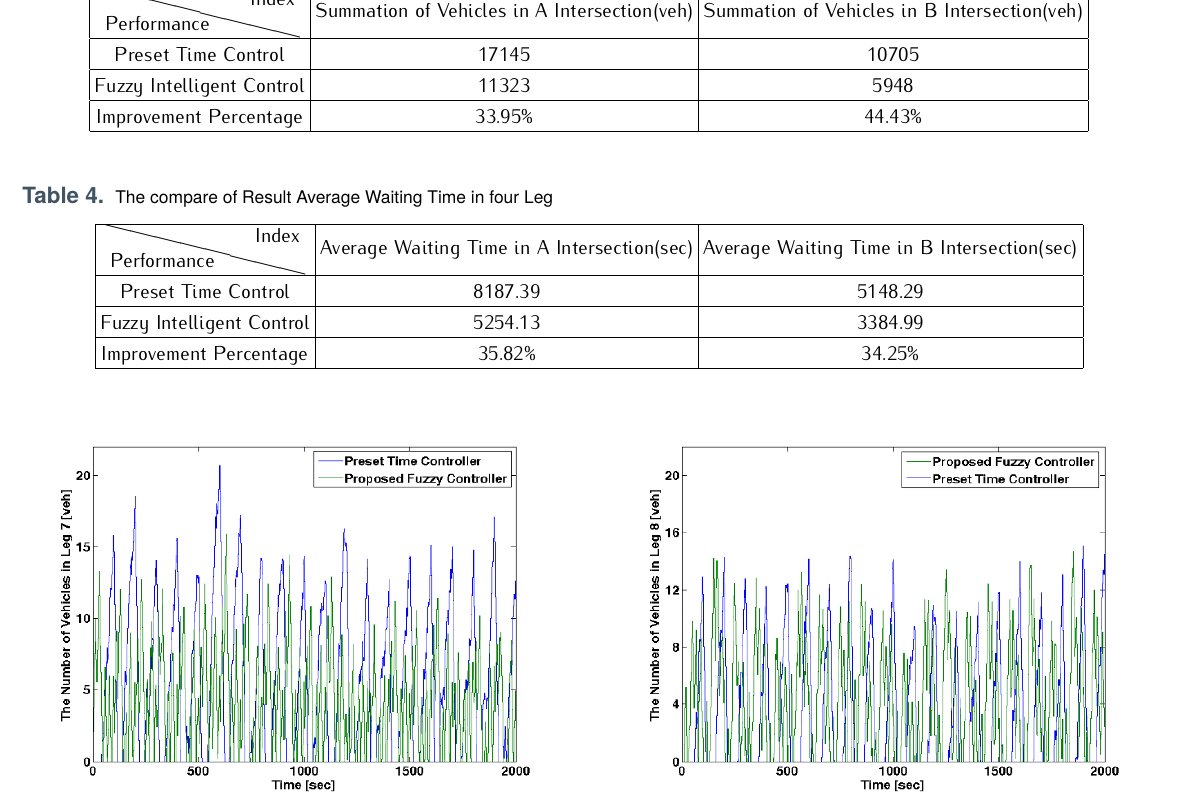
Table 3. The Compare of Results Queues Length in Two Control Methods (cid:88)(cid:88)(cid:88)(cid:88)(cid:88)(cid:88)(cid:88)(cid:88) Performance